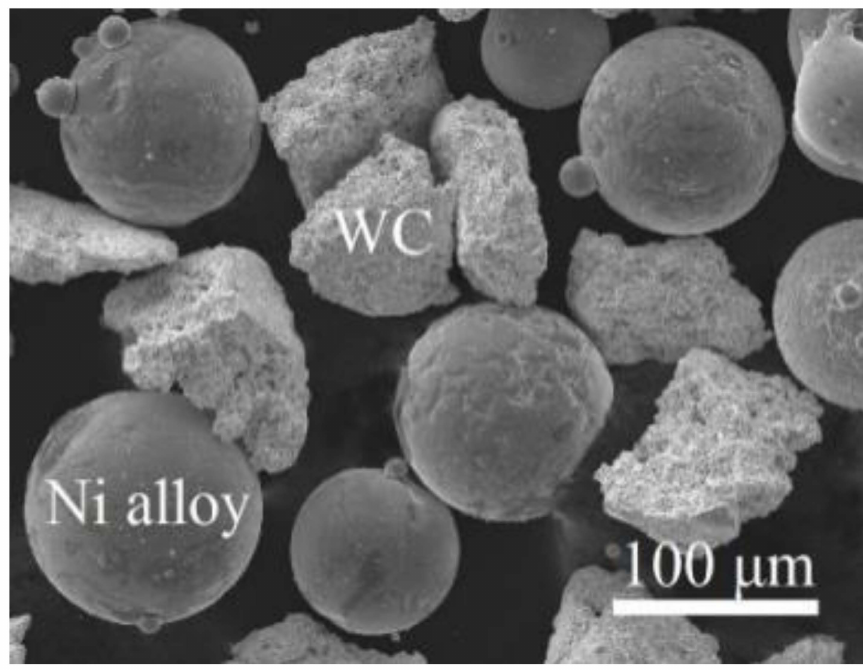
Figure 1. SEM micrograph of the powder used for coatings